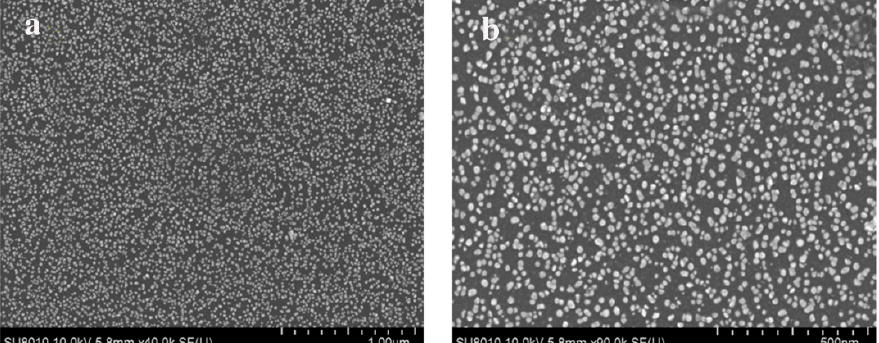
Figure 1. Scanning electron microscopic images of gold nanoparticles modified glassy carbon electrode surface.